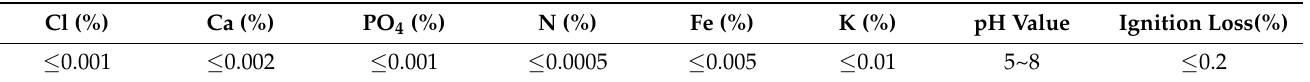
Table 9. Physical properties of anhydrous sodium sulfate.